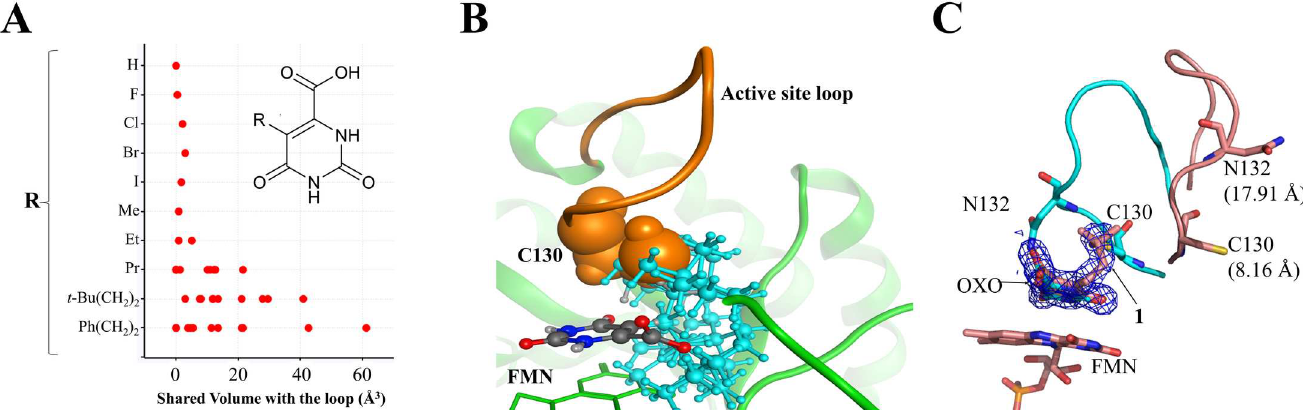
Fig 1. Generation of OF inducer. (A) Shared volume betweenvarious conformers of the 5-substituent group (inset) and C130 from the active site loop. The graph was generatedusing coordinatesfrom the TcDHODH-orotate complex structure (2E6A)[16] and calculatedusing MOE[41]. (B) Superposition of variousconformations of 1 generated by MOE[41] to the active site of the TcDHODH-orotate complexstructure. FMN and TcDHODH are shown in green as stick and ribbon,respectively.The active site loop and C130 are shown in orange.Different conformations of 1 are shown as ball-and-stick with carbon, nitrogenand oxygen coloredin gray, blue, and red respectively. For better visualization, all atoms from the t -butyl-ethyl moiety are colored in cyan. (C) Superposition of the B chain from TcDHODH-1 (3W1Q, salmon)and -oxonate(2E6F, cyan)[16]complex structures. The electron density map, contouredat 1 σ , from 1 is shown. C130 and N132 residues are representedas stick. The distancemoved relative to the respectivepositionsfrom the TcDHODH-oxonate complexstructure (2E6F)[16]for S γ group (C130) and N δ 2 (N132) are shown in